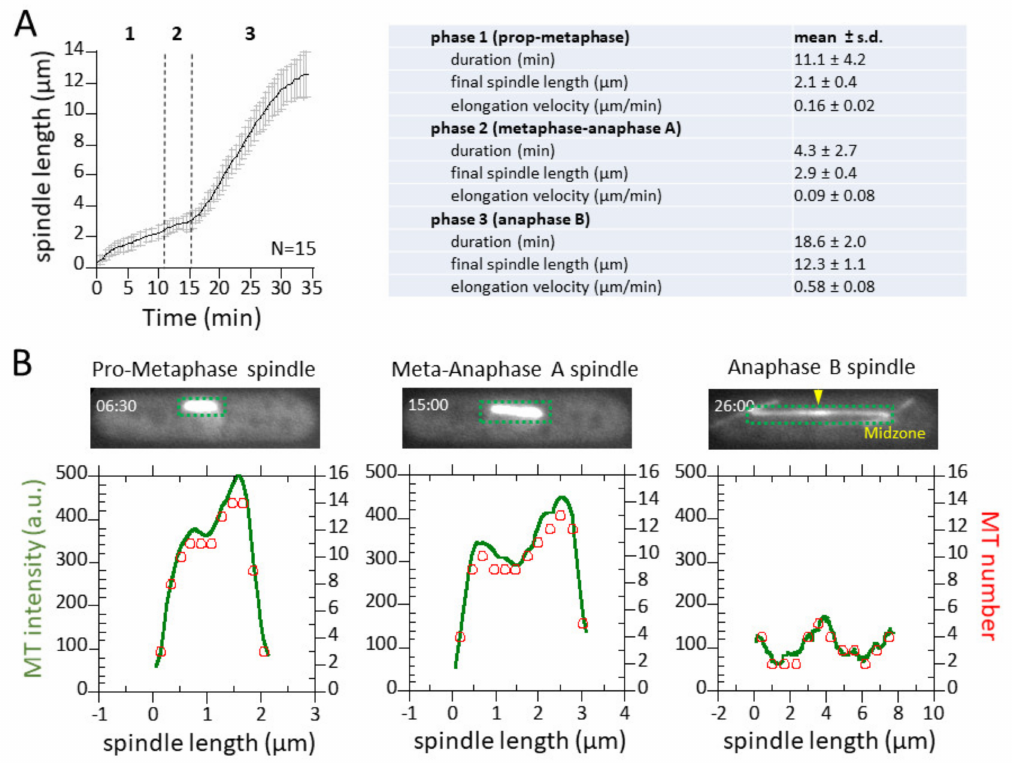
Figure 3. Spindle dynamics and corresponding MT intensity and number. ( A ) Plot of spindle length versus time. Shown are mean length ± s.d. for 15 wild-type fission yeast cells. Summary table of spindle dynamics for 15 wild-type fission yeast cells. ( B ) Representative plots of spindle fluorescence intensities for three different time points or spindle lengths (green). The intensities are converted to MT number (red) by dividing the total intensity over the mean intensity of one